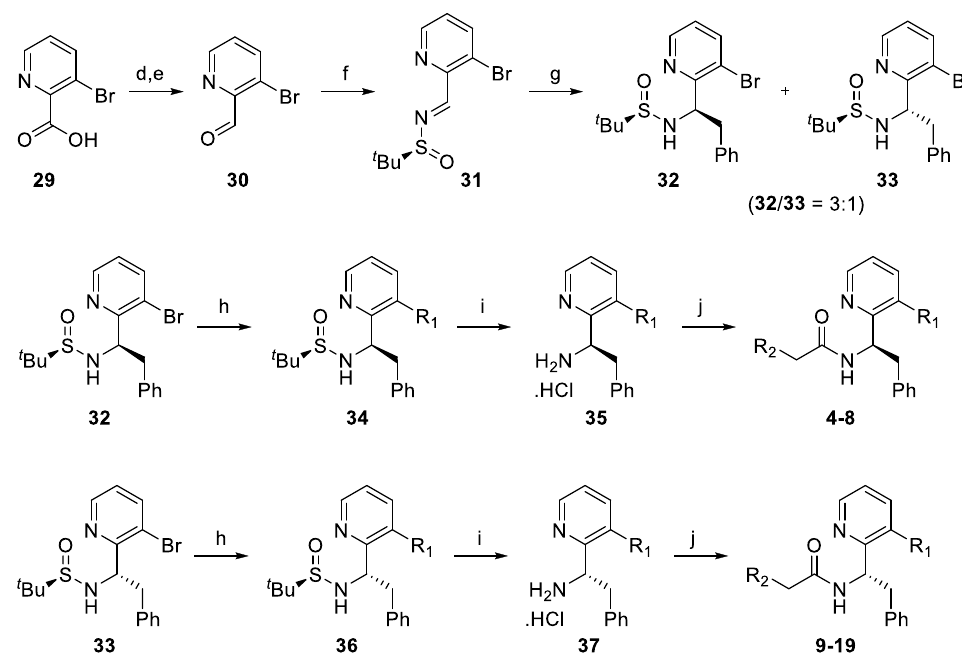
Figure 2. Design of conformationally constrained chemotypes based on